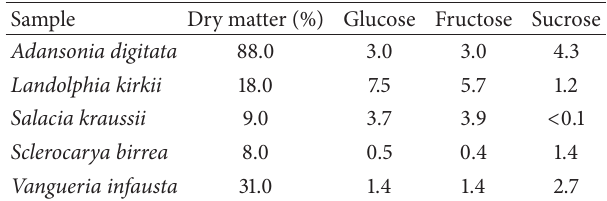
The variation between duplicate determinations was below 15%.